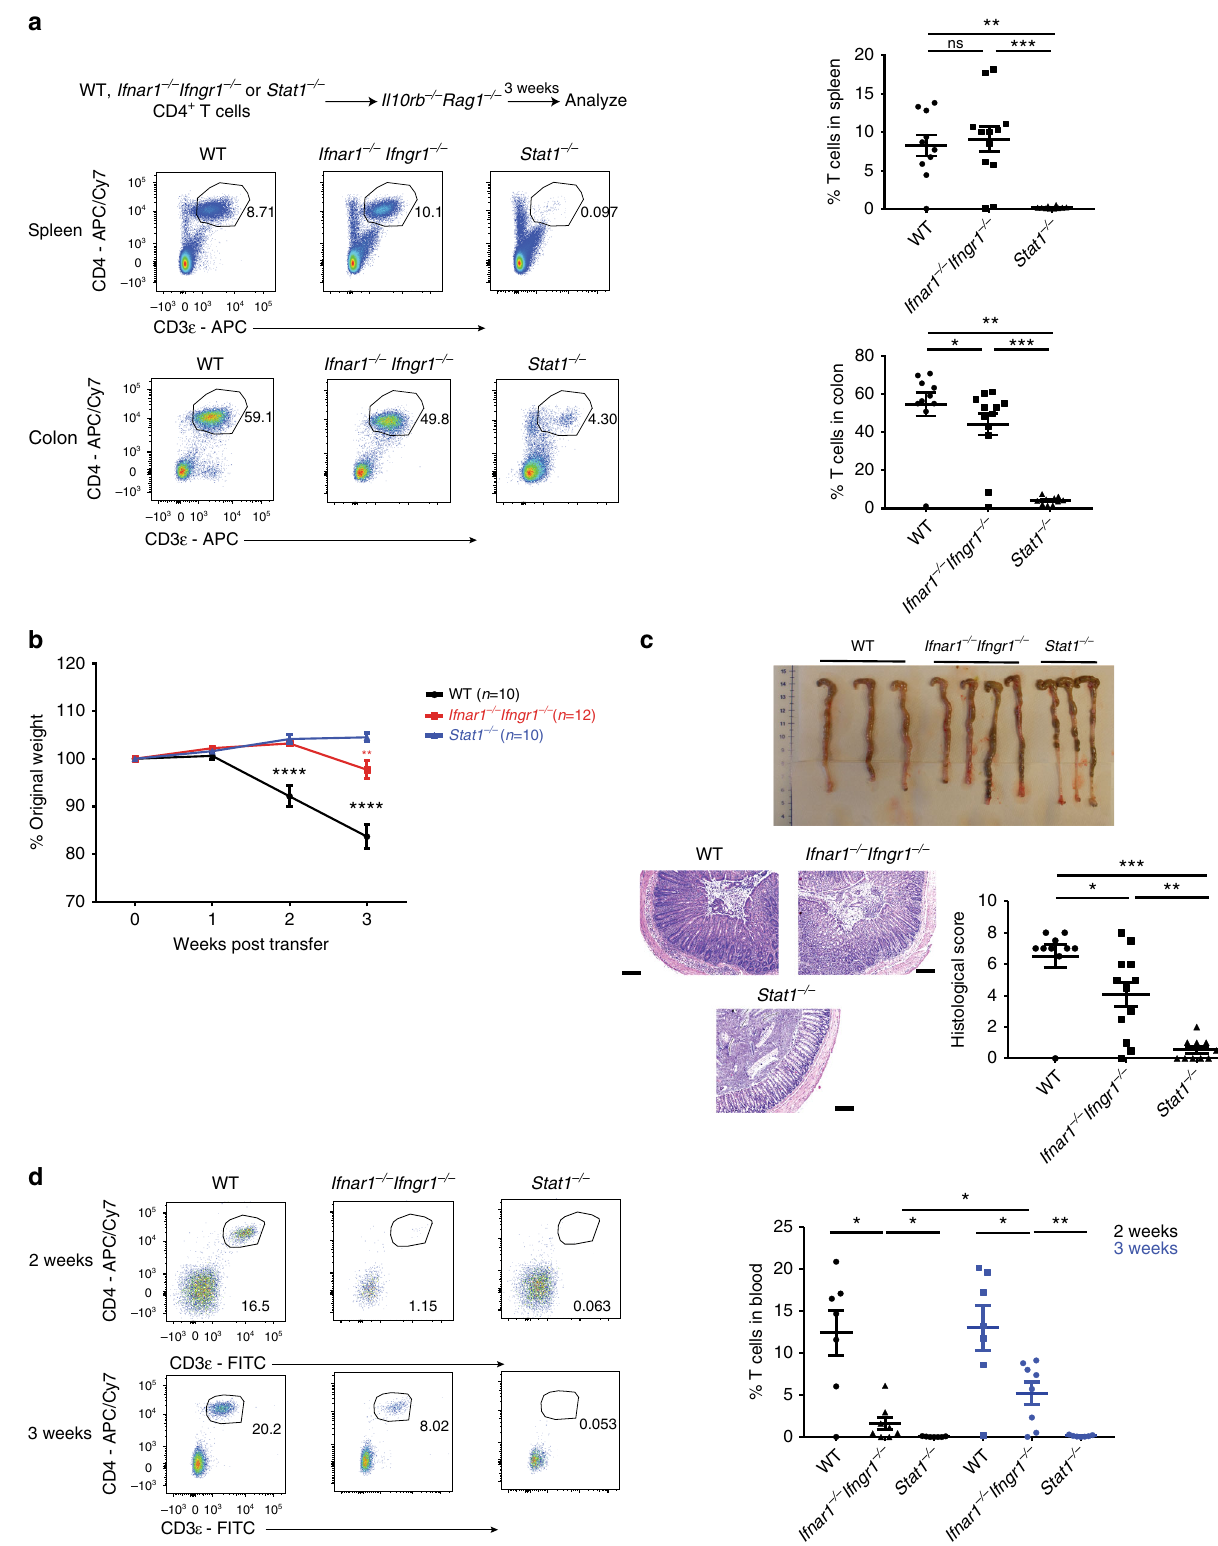
promoting Th1 differentiation (through the induction of T-bet) and inhibiting Th17 differentiation 3,4,7 . In IBD, previous stu- dies on STAT1 signaling in T cells focused on the STAT1- dependent transcription factor T-bet 13,23 . While it was noted that Stat1 − / − T cells were unable to cause colitis, the pro fi le of